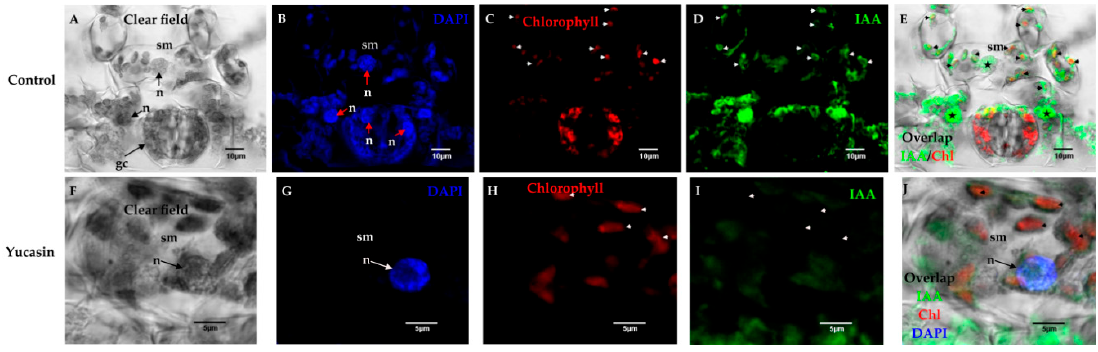
Figure 7. Free IAA immunolocalization on Day 0 of the SE induction process in C. canephora . Confocal microscopy images of cross-sections of leaf explants 0 dai of SE. ( A ), clear field; ( B ), nuclei staining with blue DAPI; ( C ), red chlorophyll signal; ( D ), free IAA signal in green; and ( E ) overlapping of the free IAA and chlorophyll signals. Note that there was IAA in the chloroplasts (short white arrows) and nucleoplasm (bold stars) of the spongy mesophyll (sm) cells; ( F ), light field; ( G ), nuclei staining with DAPI in blue; ( H ), chlorophyll signal in red; ( I ), free IAA signal in green color; ( J ), overlapping of IAA signal, chlorophyll, and DAPI on Day 0 of SE induction. IAA was not in the chloroplasts or the nucleoplasm of the spongy mesophyll cells, but in the cytosol. Mesophyll cells: sm; nucleus: